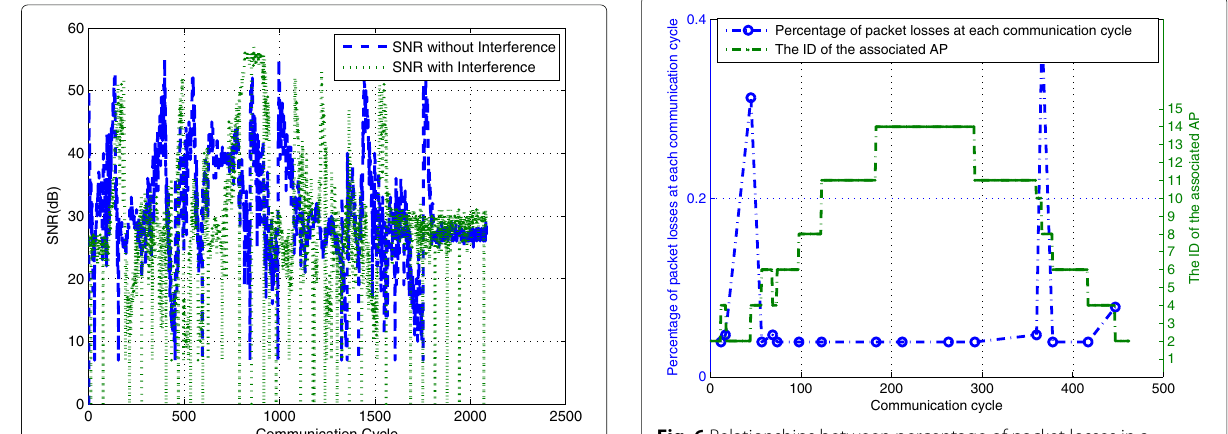
Fig. 6 Relationships between percentage of packet losses in a communication cycle and the associated AP at each communication cycle when interference does not